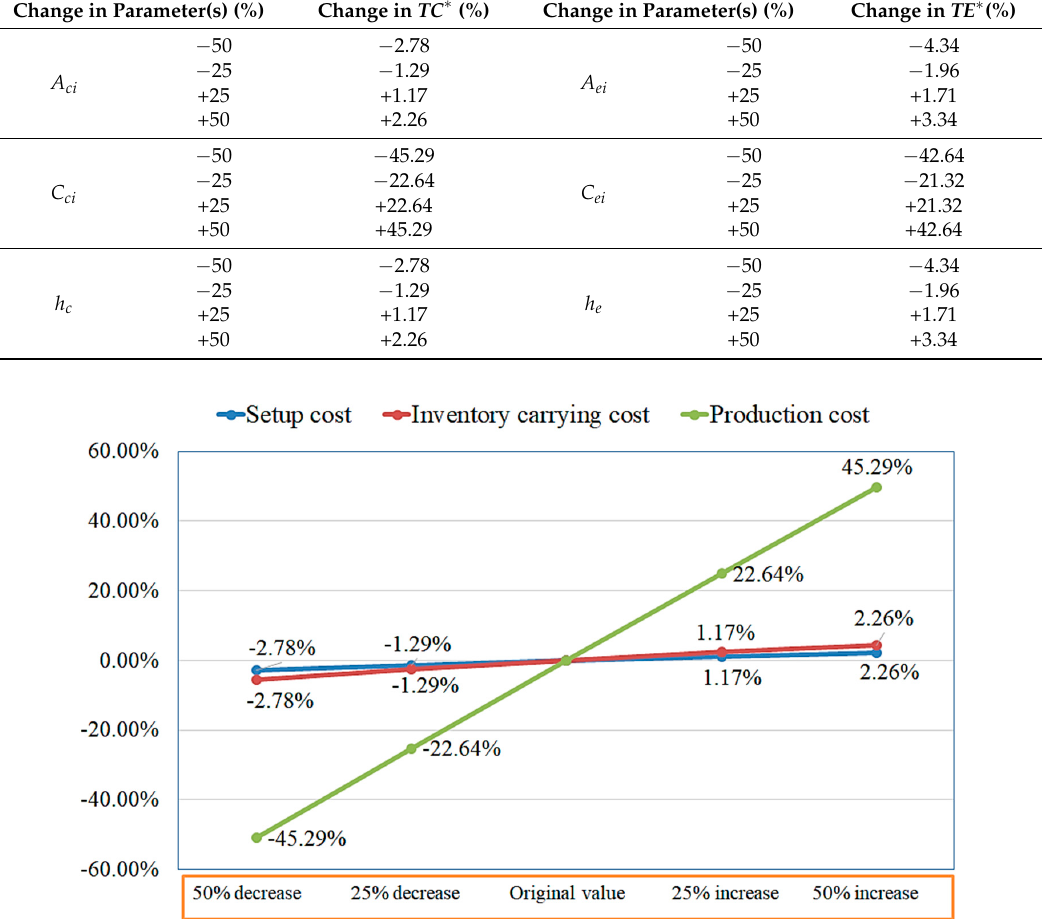
Figure 6. Sensitivity analysis of cost objective for the model with uncertain information. Mathematics 2018 , 6 , x FOR PEER REVIEW